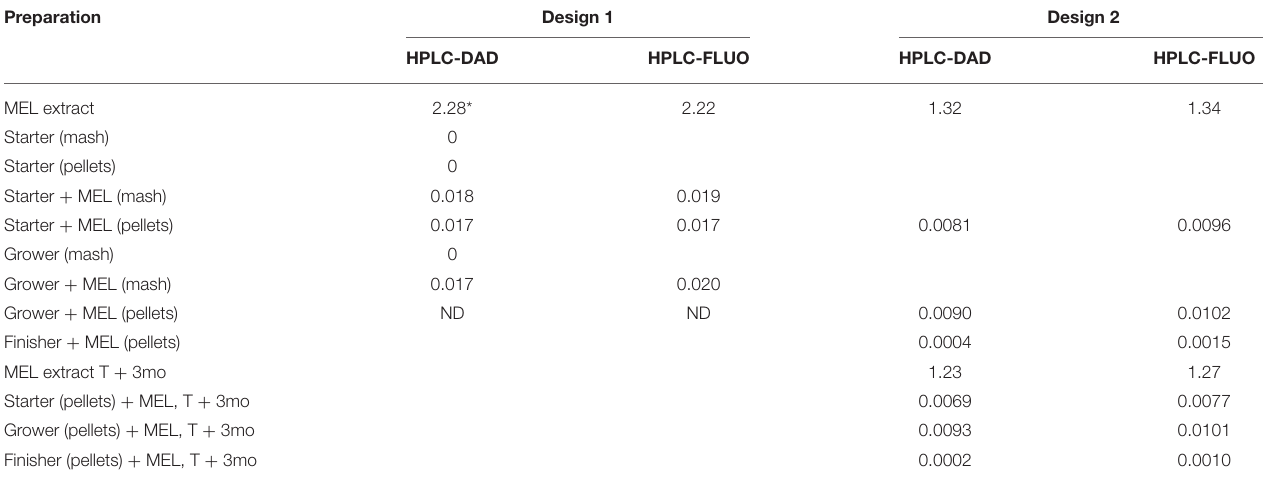
TABLE 5 | Proportion of RA in MEL extracts and in supplemented